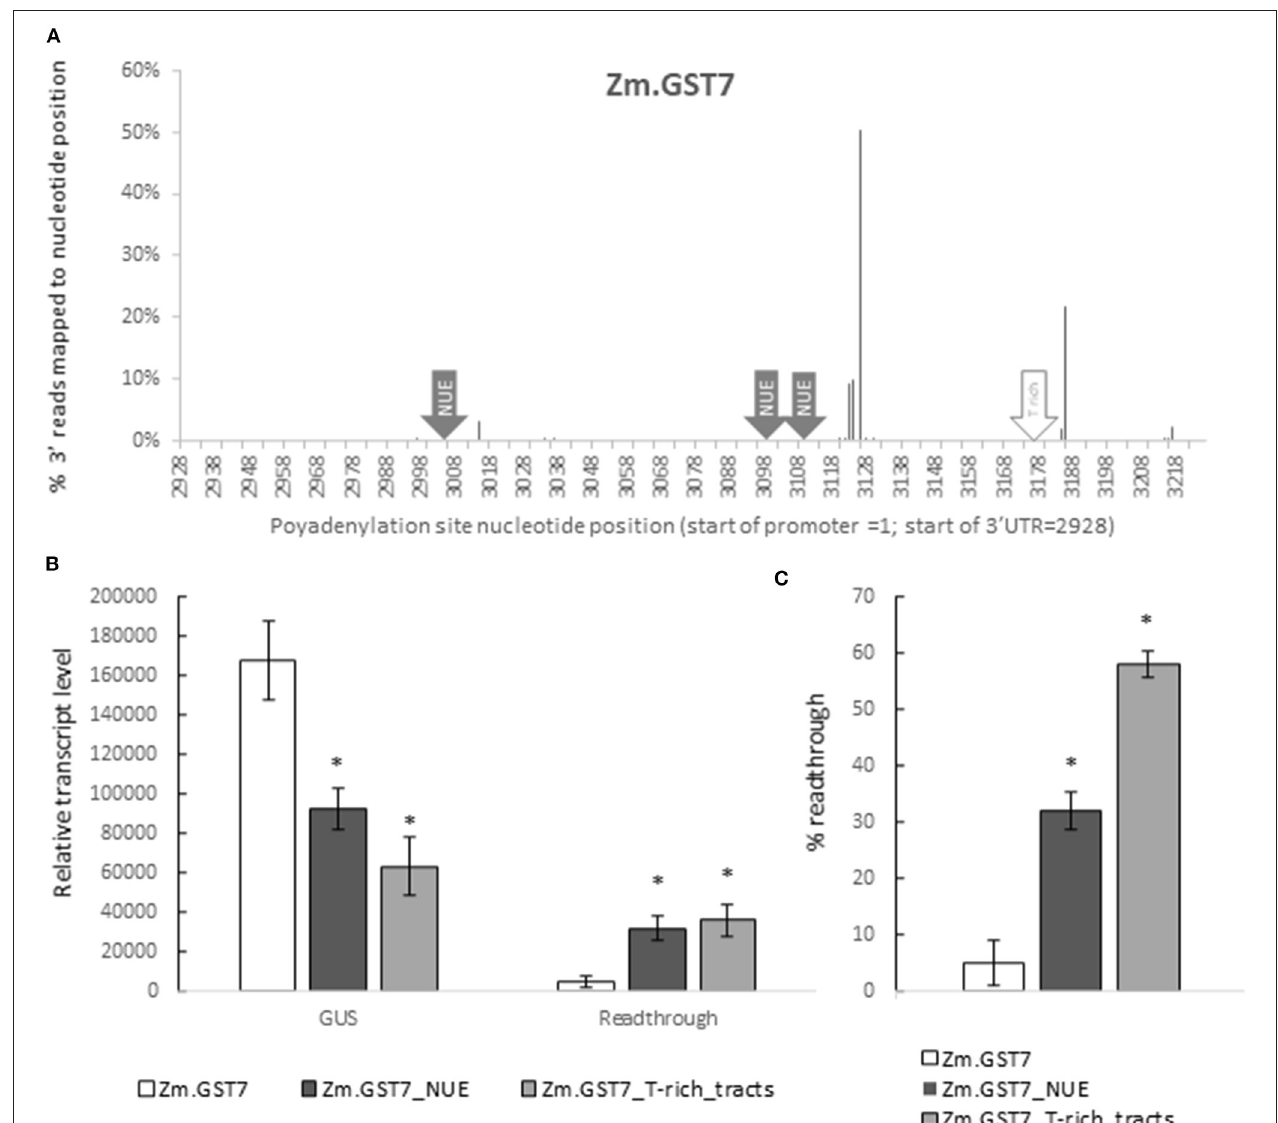
FIGURE 8 | GST7 enables effective transcript termination as predicted. This function is dependent on functional polyadenylation and cleavage signals. 3 ′ polyadenylation sites for GUS reporter gene with Zm.GST7 were characterized by sequencing (A) . 3 ′ ends of GUS transcript fragments from leaf RNA were captured and sequenced by high throughput sequencing. About 12 independent transgenic events were characterized to produce 479,738 reads mapped to the expression cassette after trimming. About 3,219 of these mapped reads with the 3 ′ sequencing adapter were identified as polyadenylation sites. The resulting sequencing reads were pooled to report the polyA site distribution as % reads mapped to each nucleotide position. Nucleotide positions are reported with the 5 ′ most position of the promoter = 1.GUS transcripts and read through from reporter genes with Zm.GST7 and variants in the NUE polyadenylation signal and T-rich tract cleavage site signals were analyzed by qRT-PCR (B,C) . GUS and read - through transcripts were detected by primer/probe sets in the GUS-coding sequence and downstream of the 3 ′ UTR, respectively. Transcript levels within each tissue are normalized by two [-DeltaDeltaC(T)] methods and reported as a relative expression value. At least 12 independent transgenic events were analyzed, and the data are reported as the mean with standard error. Percent read through is calculated by normalizing read - through transcript to GUS transcript (C) . *Indicates a statistically significant difference between original and mutant variants with corrections to control for false discovery in multiple